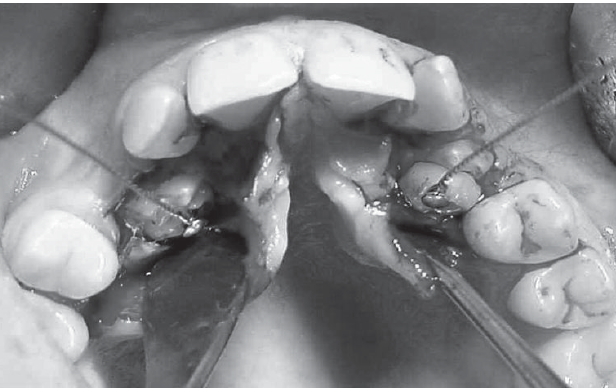
Fig.10: Osteotomy and bonding the orthodontic accessory.